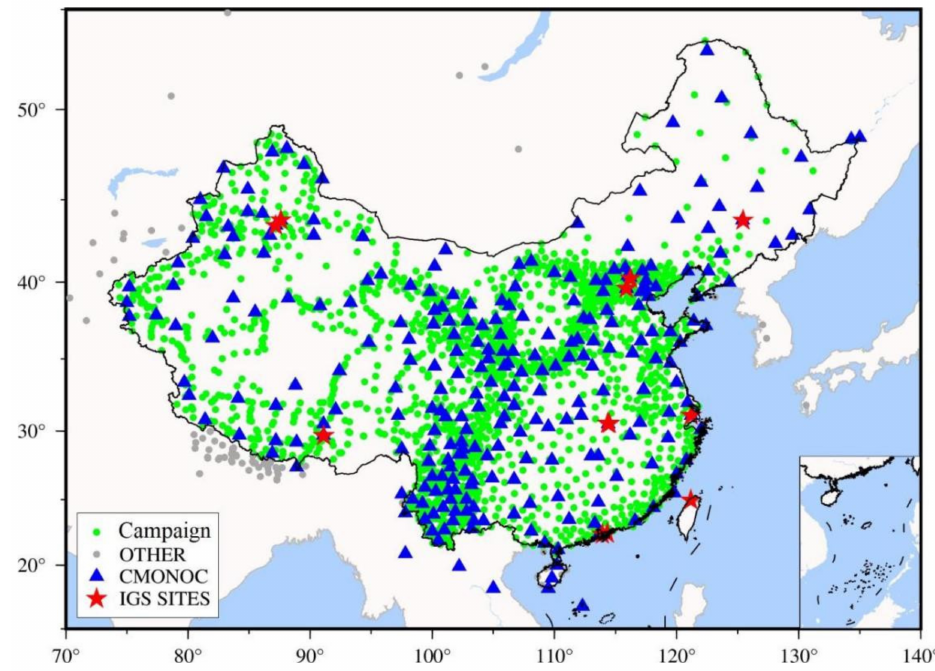
Figure 2. GNSS sites in continental